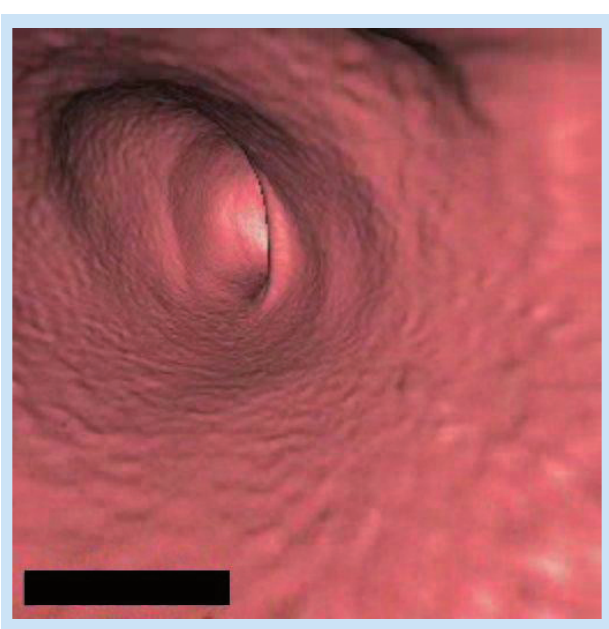
Fig. 3. Example of irregular